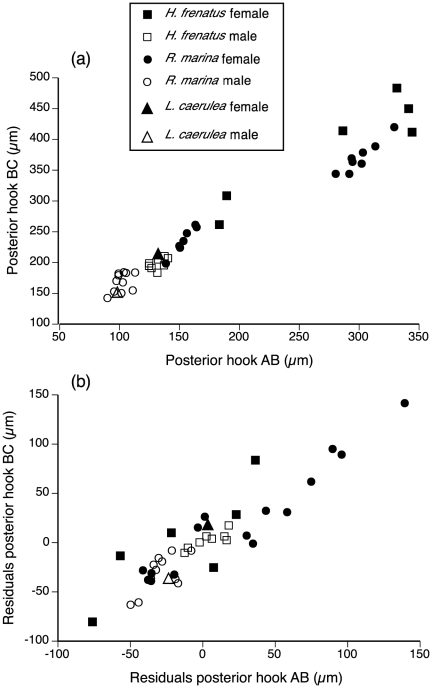
Barb length (AB) versus overall length (BC) of posterior hooks of Raillietiella frenatus from Rhinella marina, Hemidactylus frenatus, and Litoria caerulea.(a) Raw hook measurements uncorrected for pentastome body size, note two visible clusters. (b) Hook measurements corrected for pentastome body size (by calculating residual scores from a linear regression of hook measurements against pentastome body size), note that clusters now disappear.